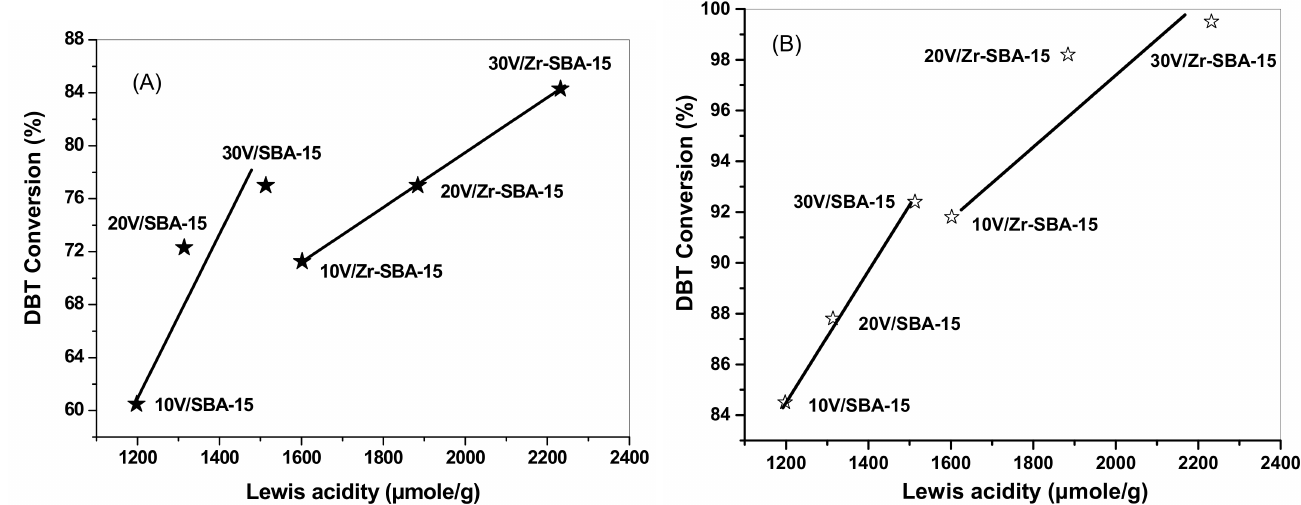
Figure 11. DBT conversion as a function of Lewis acidity of the catalysts. ( A ) DBT conversion data were obtained at 40 ◦ C after 60 min of reaction and the Lewis acidity data were obtained at 100 ◦ C. ( B ) DBT conversion data were obtained at 60 ◦ C after 20 min of reaction and the Lewis acidity data were obtained at 100 ◦